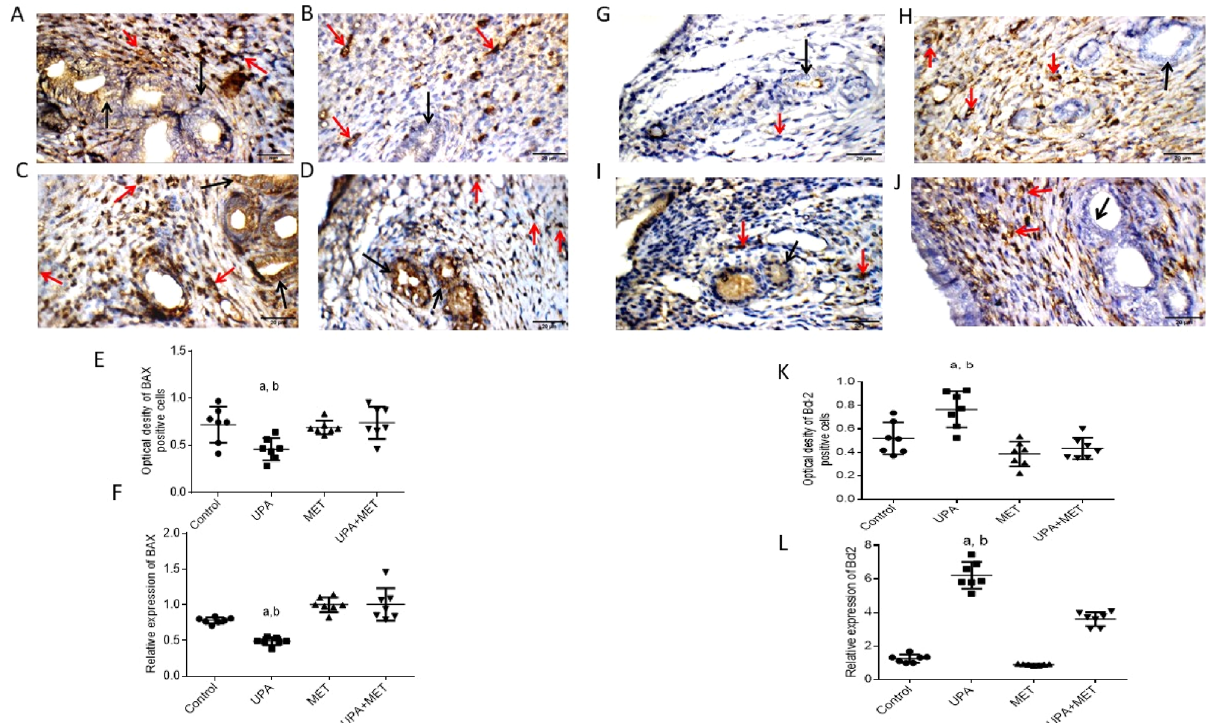
Figure 3. Effect of metformin or/and ulipristal on the expression of the apoptosis markers of rats’ uteri. ( A – D ) photomicrographs of uteri shows expression of apoptotic marker Bax. ( A ) Uterine wall in the control group. ( B ) Uterine wall in ulipristal treated group. ( C ) Uterine wall in metformin treated group. ( D ) Uterine wall in the ulipristal and metformin treated group. × 400 magnification (scale bar = 20 μm). ( E ) Expression quantification of the optical density reactivity of positive cells of Bax by the ImageJ analysis system. ( F ) Quantitative RT-PCR analysis of Bax mRNA expression. ( G – J ) photomicrographs of uteri shows expression of anti-apoptotic marker Bcl-2. ( G ) Uterine wall in the control group. ( H ) Uterine wall in ulipristal treated group. ( I ) Uterine wall in the metformin treated group. ( J ) Uterine wall in the ulipristal and metformin treated group. × 400 magnification (scale bar = 20 μm). ( K ) Expression quantification of the optical density reactivity of positive cells of Bcl-2 by the ImageJ analysis system. ( L ) Quantitative RT-PCR analysis of Bcl-2 mRNA expression. Black arrow refers to reactivity in endometrial glands, red arrows refers to reactivity in stromal cells. Data in figures ( E ) and ( K ) is represented by mean ± SD (n = 7). All value of RT-PCR is expressed as the change in cycle threshold (ΔCt). Each dot represents mean of each group (n = 7, triplicate for each rat). Negative control (DEPC-treated water) showed no detectable fluorescent signals. a or b, Statistically significant from the control or ulipristal and metformin treated group respectively at P < 0.05 using one-way ANOVA followed by Tukey as a post hoc test. UPA ulipristal, MET metformin, UPA + MET co-treatment with ulipristal and